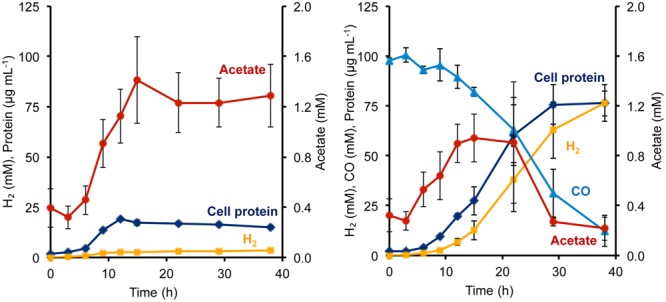
Growth characteristics of P. furiosus strain Codh in the absence (left) and presence (right) of CO with limiting yeast extract (1 g L-1). Compounds are represented as follows: blue triangles, CO; dark blue diamonds, cell protein; orange squares, H2; red circles, acetate. Error bars represent SD, n = 3.